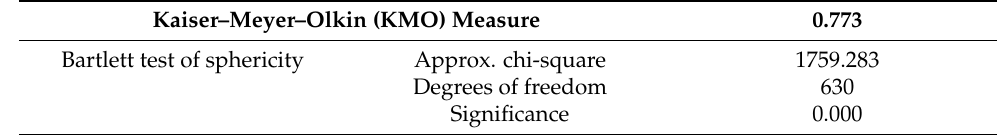
Table 7. The KMO measure and Bartlett test for observed